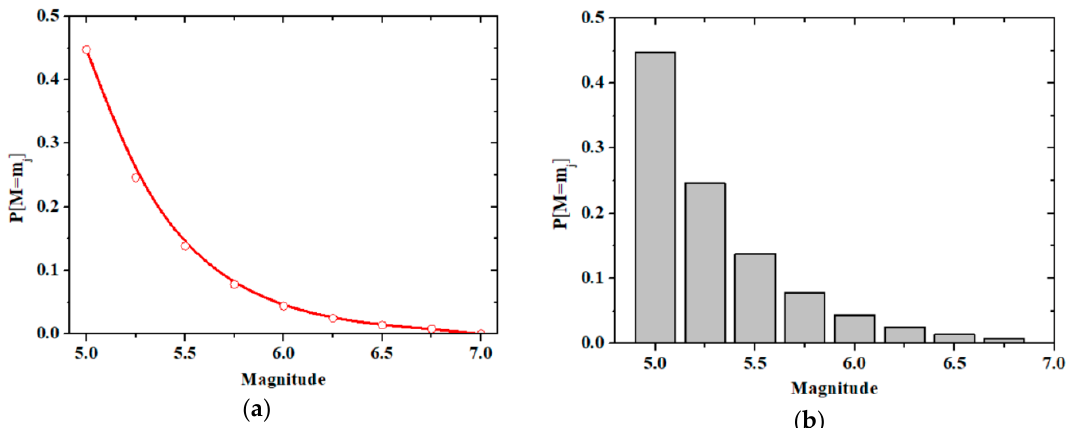
Figure 9. Magnitude distribution for a specific source with a truncated Gutenberg-Richter law: ( a ) continuous probability density function; ( b ) discrete probability density function.